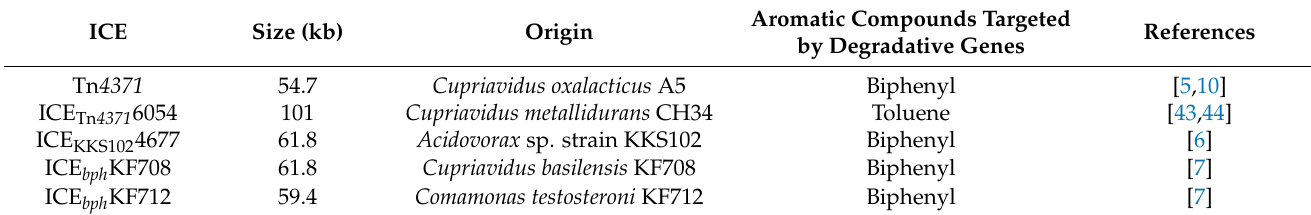
Table 2. Tn 4371 family degradative ICE